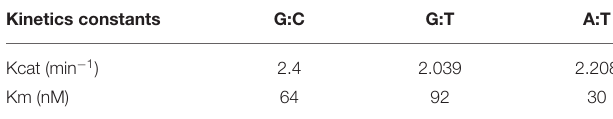
TABLE 1 | Steady-state kinetics constants for canonical bases and G:T mismatch. Kinetics constants G:C